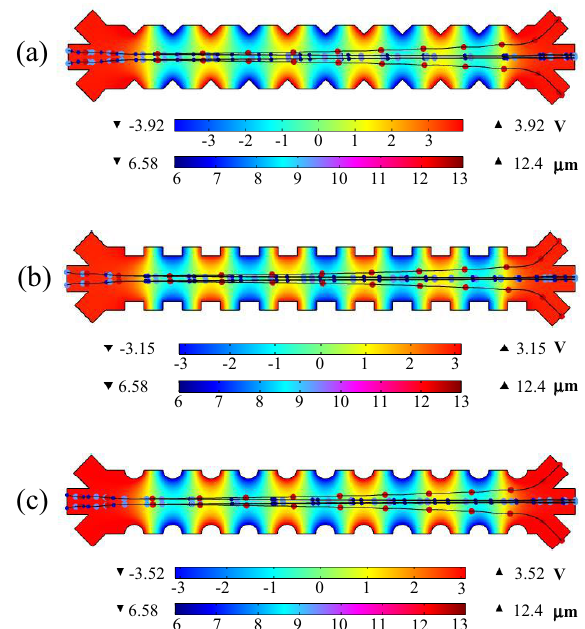
Figure 5. Spatial variation of the electric potential and trajectories of MDA-MB-231 and WBCs by applying the dielectrophoresis force for various electrode configurations ( a ) triangular ( b ) rectangular ( c ) semi-circular. The top color bar shows the applied voltage to the sidewall electrodes and the bottom color bar indicates the diameter of the